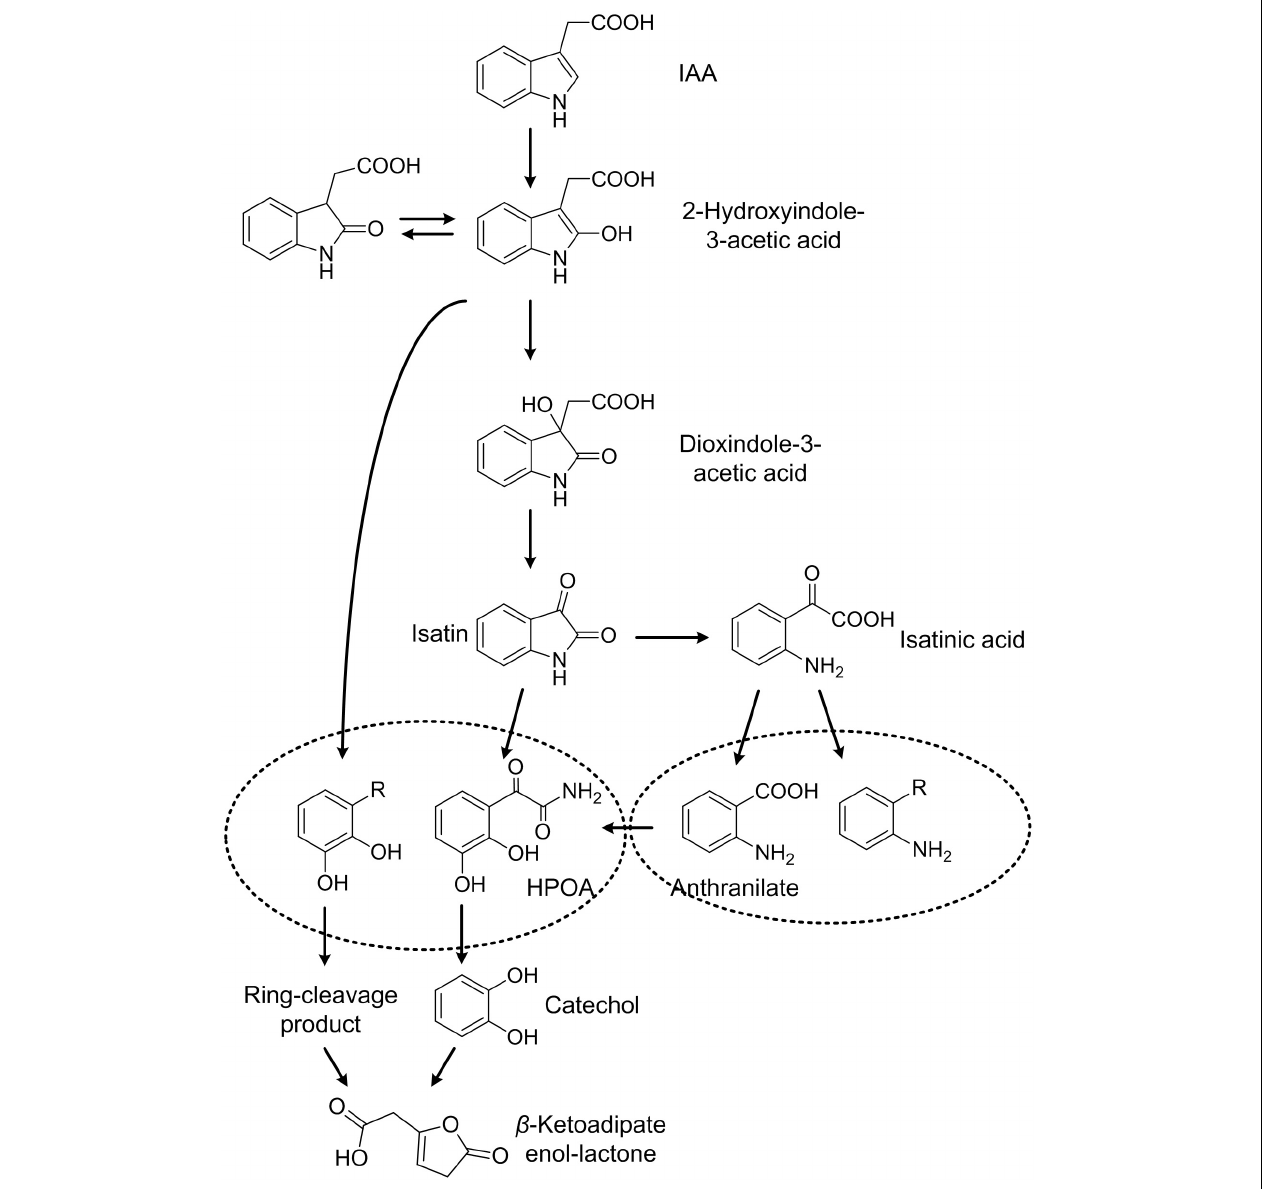
FIGURE 8 | Proposed IAA degradation in strain Pseudomonas sp.